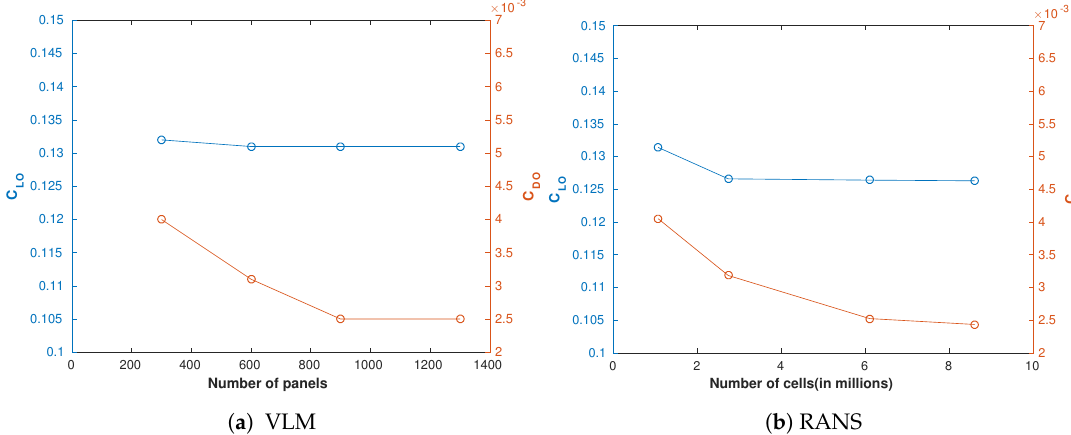
Figure 13. Grid/Panel dependence analysis for the isolated blended-wing-body aircraft configuration.